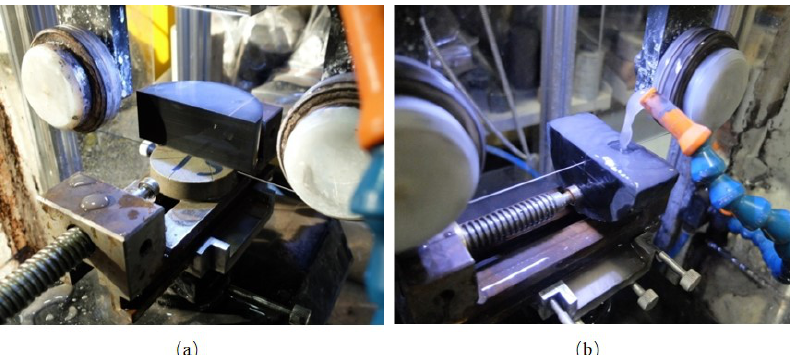
Figure 6. NSCB specimens prepared by a diamond wire cutting machine: ( a ) semicircle cut by a diamond wire cutting machine; ( b ) slit by diamond wire cutting machine.